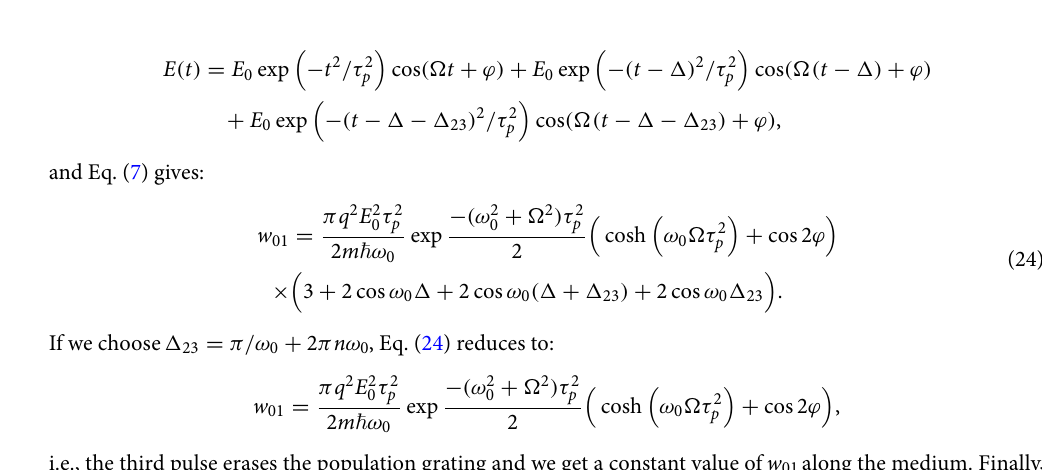
1 2 10 12 s 0.97 THz, (cid:31) . This figure was created with Matlab R2018a − = · =